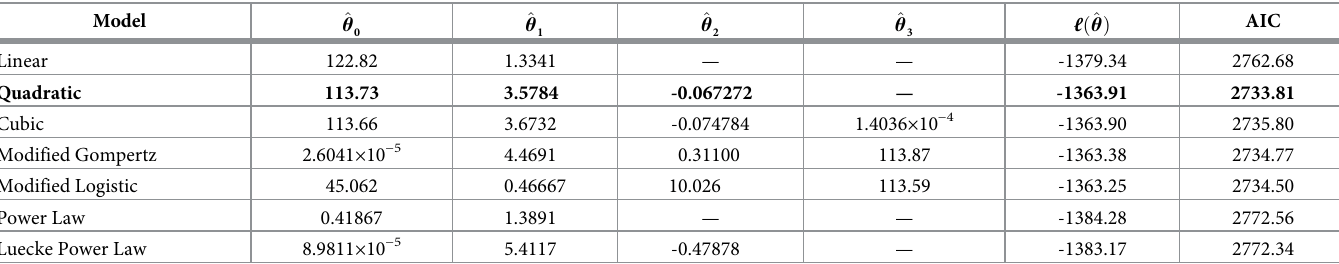
Table 17. Maternal GFR models (rate in mL/min vs. maternal mass in kg for power law models, rate in mL/min vs. gestational age in weeks for all other models).